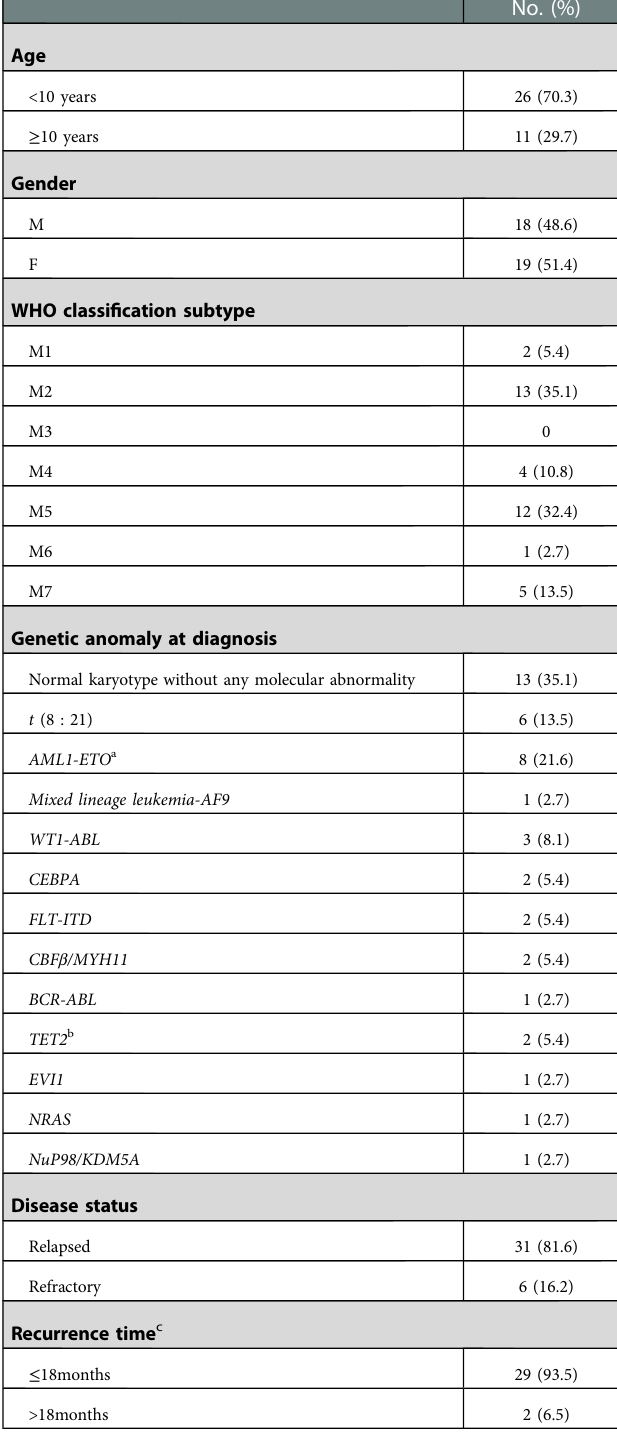
TABLE 1 Baseline characteristics of the